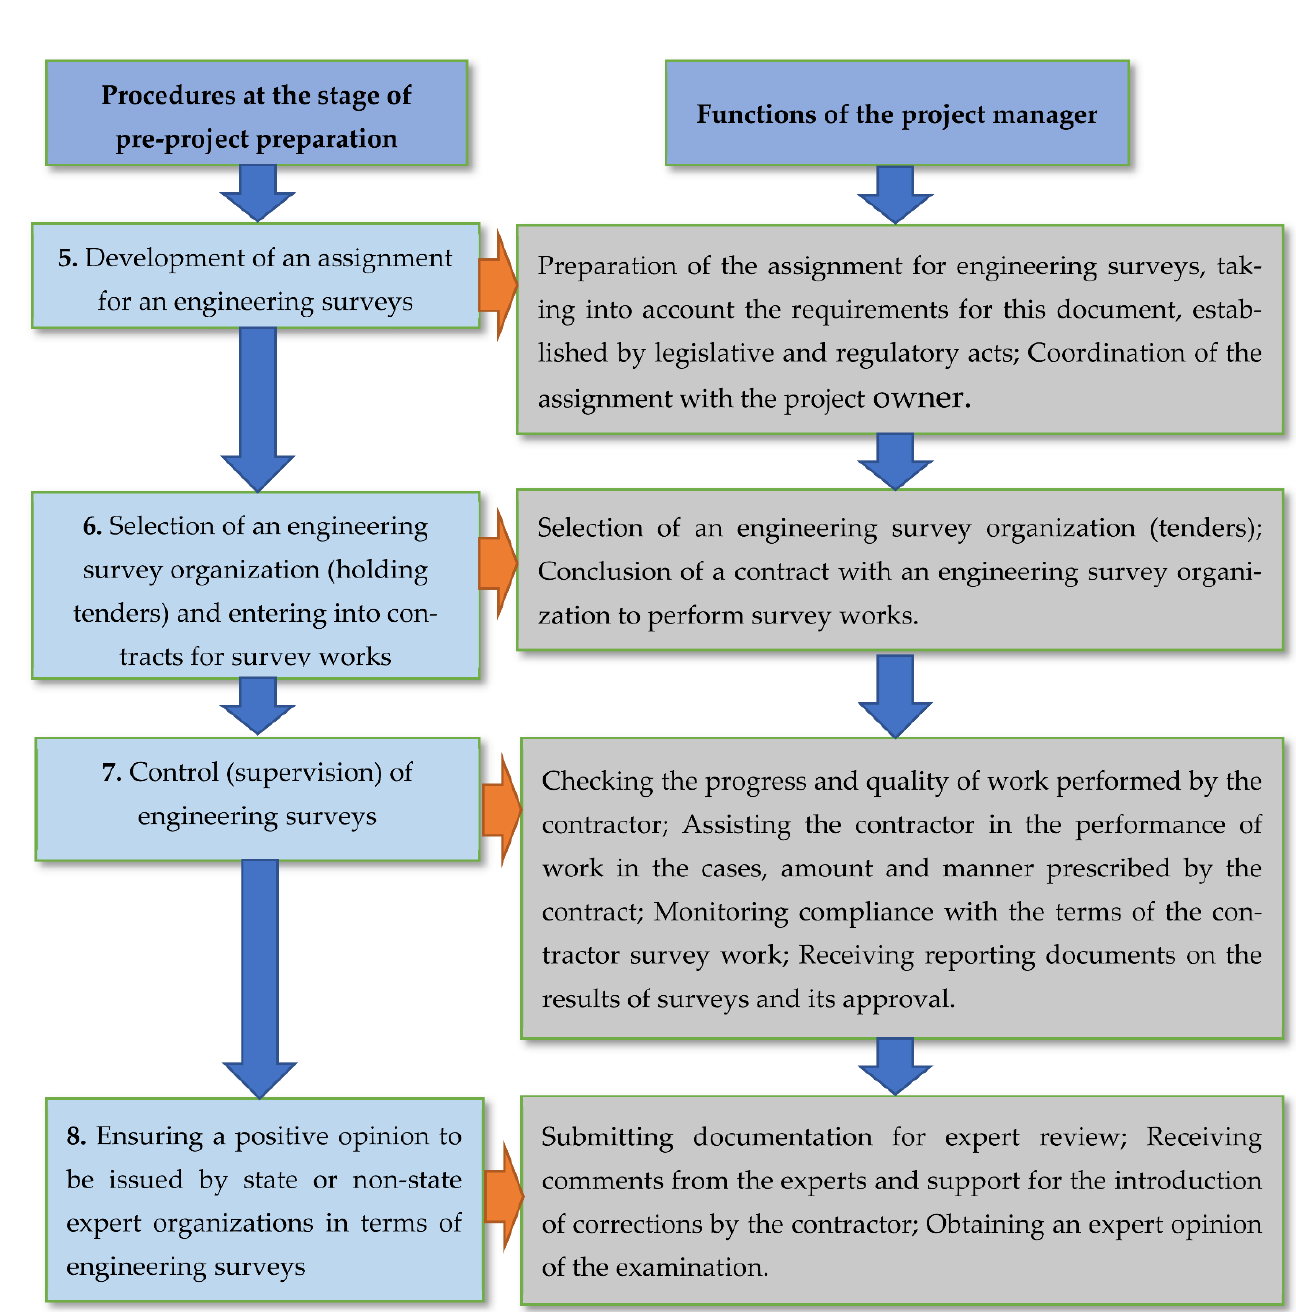
Figure 7. Consolidated procedures and functions of the project manager at the stage of pre-project preparation of a facility for construction. Part one.